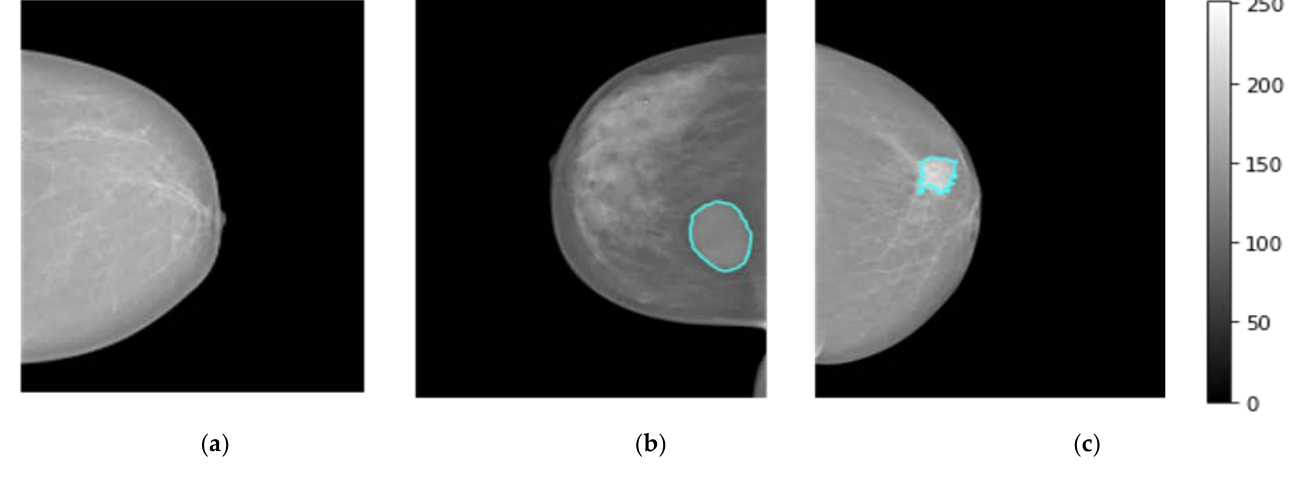
Figure 2. Examples of breast cancer mammograms from INbreast dataset (i.e., dataset1) for normal, benign, and malignant cases as depicted in ( a ), ( b ), and ( c ), respectively. The breast tumor regions of interest (ROIs) for benign or malignant cases are accurately determined by expert radiologists as they are superimposed in a blue contour on the original mammogram.